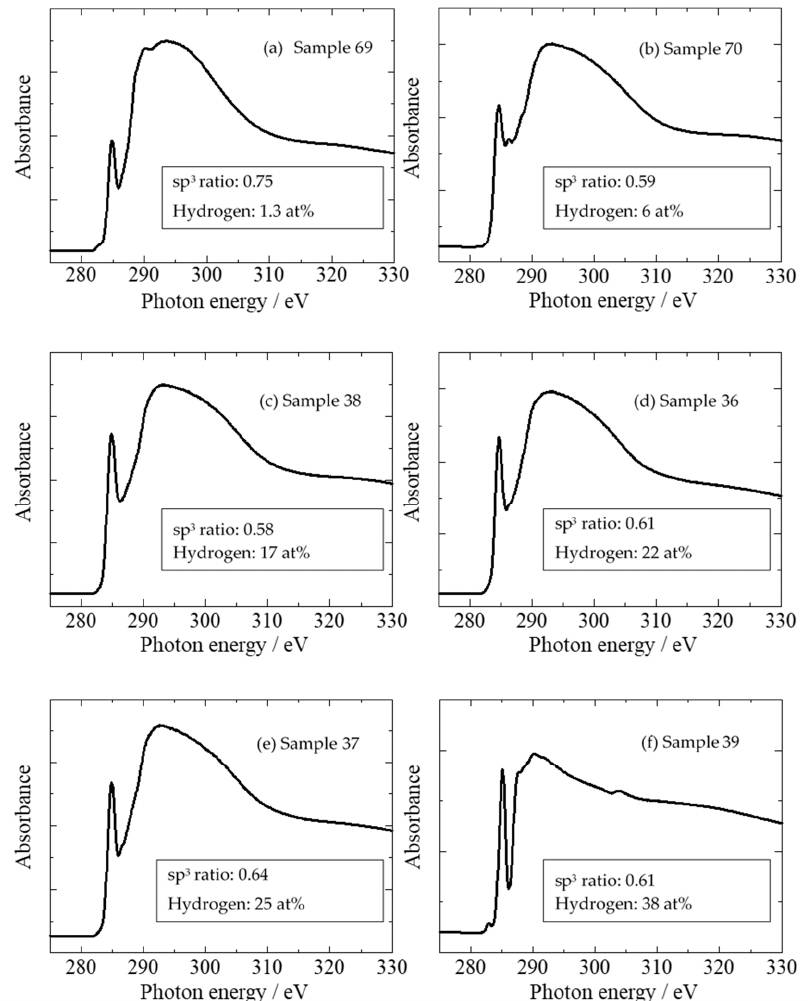
Figure 9. NEXAFS spectra of six types of amorphous carbon films. Each sample number listed here corresponds to sample number in Table 2.